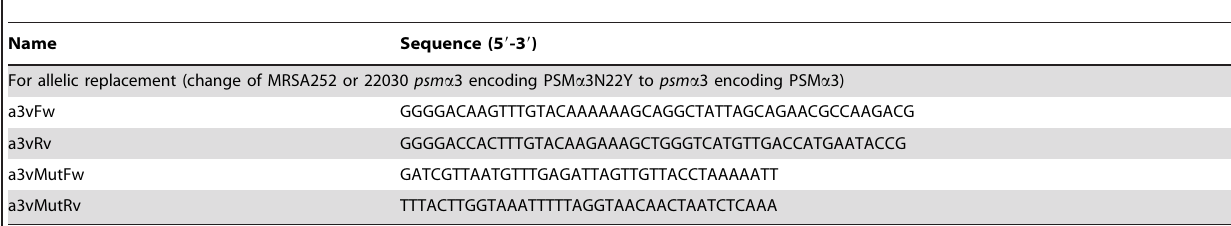
Table 1. Oligonucleotides used in this